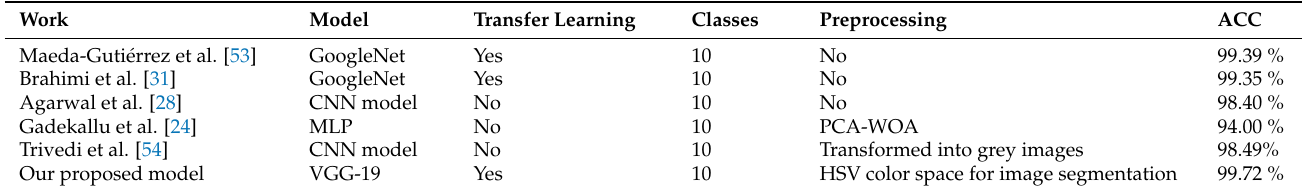
Table 7. Tomato leaf disease comparison between previous methods and